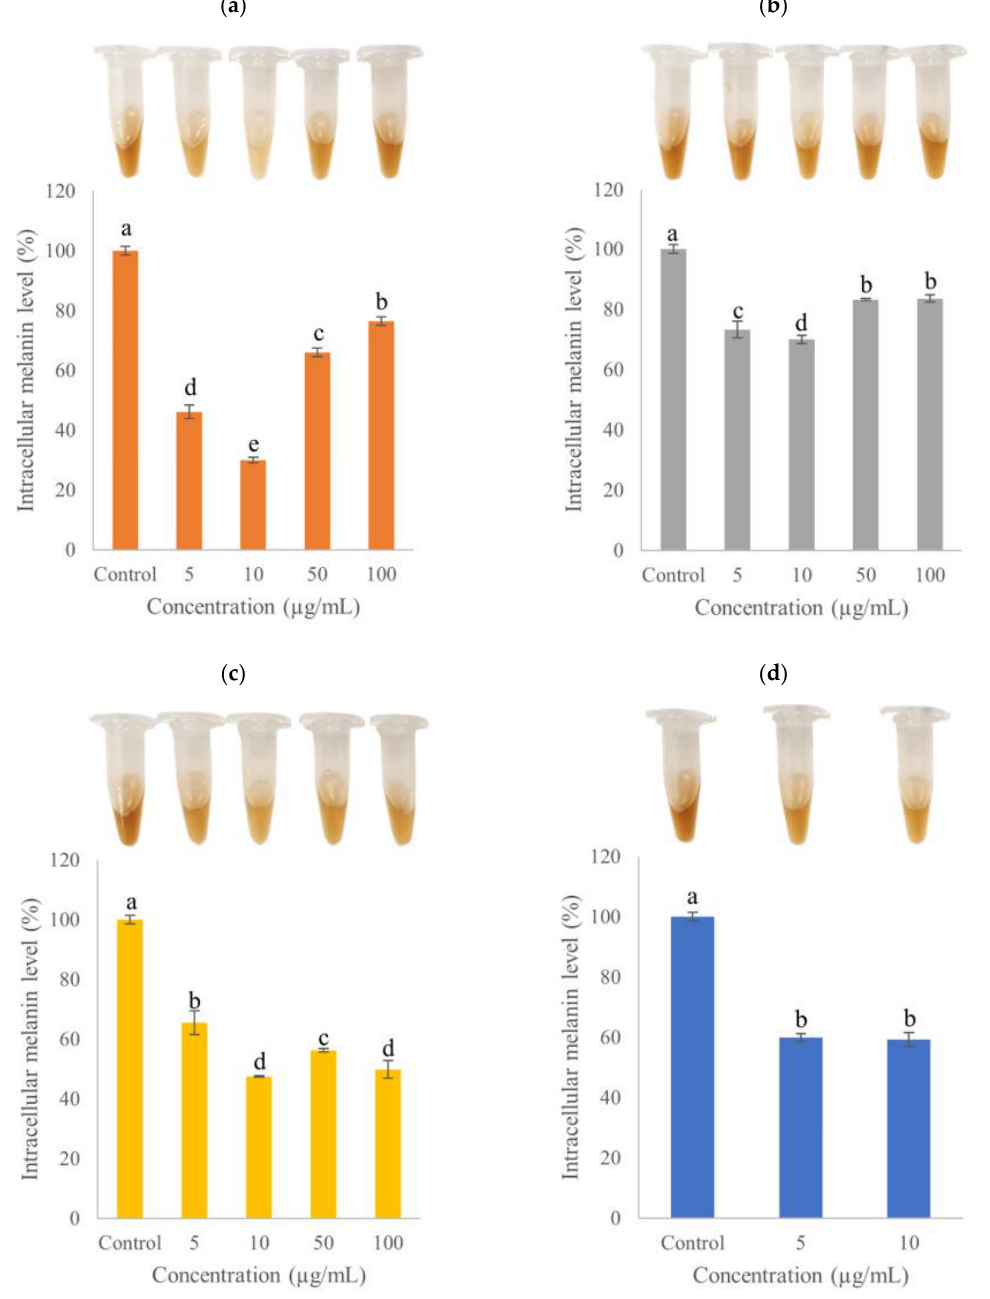
Figure 4. Effects of various concentrations of ( a ) GYSLGNWVCAAK, ( b ) CEWH mono , ( c ) CEWH di and ( d ) EGCG on the intracellular melanin level of B16F10 melanoma cells. Note: Results were reported as the mean ± standard deviation ( n = 3); different lowercase letters above the bars indicate significant difference at p < 0.05 according to Duncan’s test.